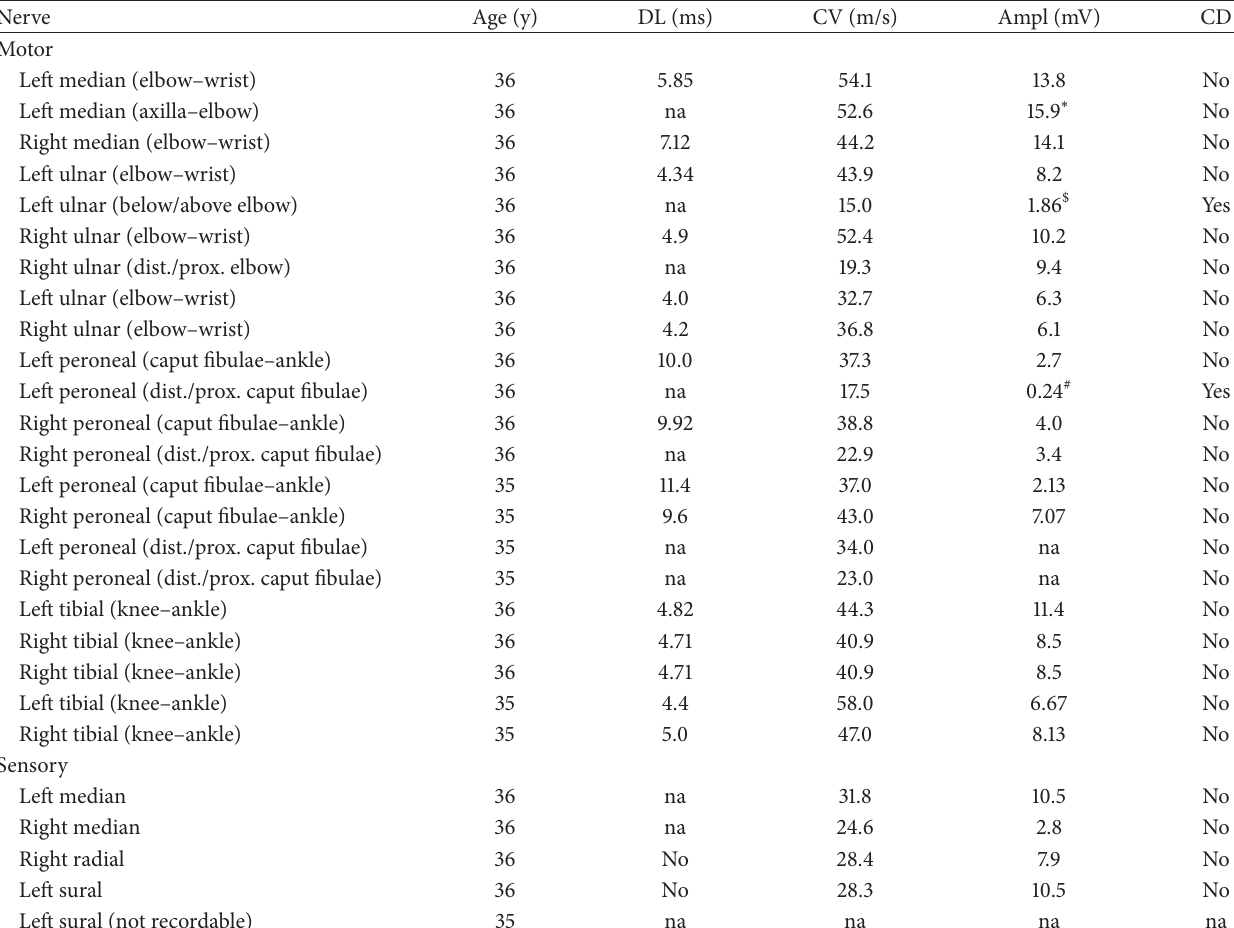
Table 1: Nerve conduction studies at age of 35 y and 36y in the presented patient. Nerve